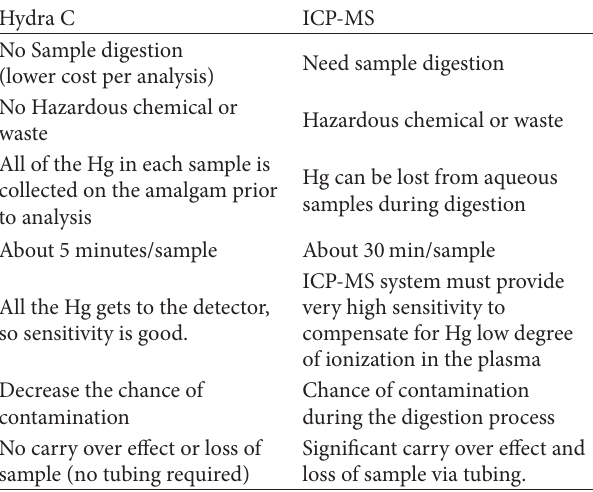
Table 6: Comparison and practical considerations for using